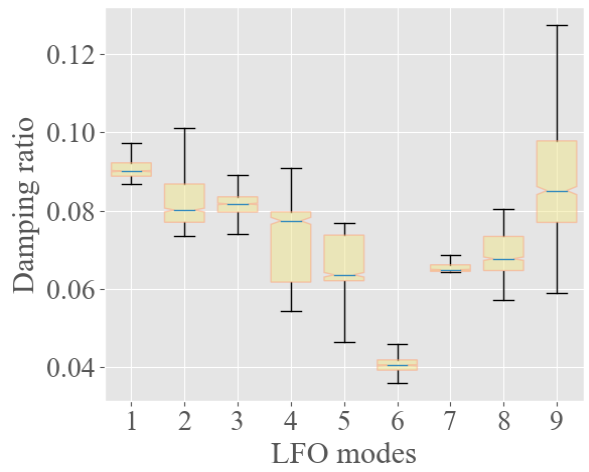
Figure 3. Box plot of damping ratio of LFO modes.